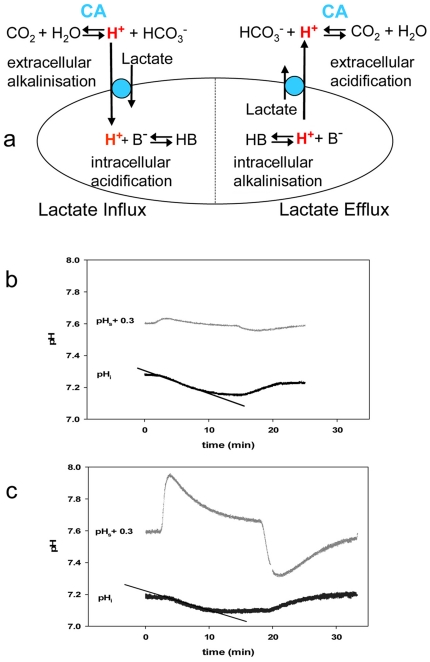
Lactic acid fluxes in mouse EDL fibers.a) Schematic representation of the mechanisms of H+ production and H+ buffering associated with lactic acid influx and efflux in skeletal muscle. Fluxes can be quantitated by following the changes in intracellular pH. The changes in surface pH illustrate the associated processes of proton consumption or production on the surface membrane. b) pHS and pHI during exposure to and after subsequent withdrawal of lactate in the bathing solution in a WT EDL fiber. c) pHS and pHI during the same maneuver as in 2b in a CA IV-CA XIV double ko mouse EDL fiber. Lactate fluxes are decreased in comparison to 2b and pHS transients are greatly enhanced. Note that pHS curves in b and c are shifted on the pH ordinate by + 0.3 units to improve visibility. The standard bathing solution is Krebs-Henseleit solution, pH 7.4, at room temperature and equilibrated with 5% CO2/95%O2.